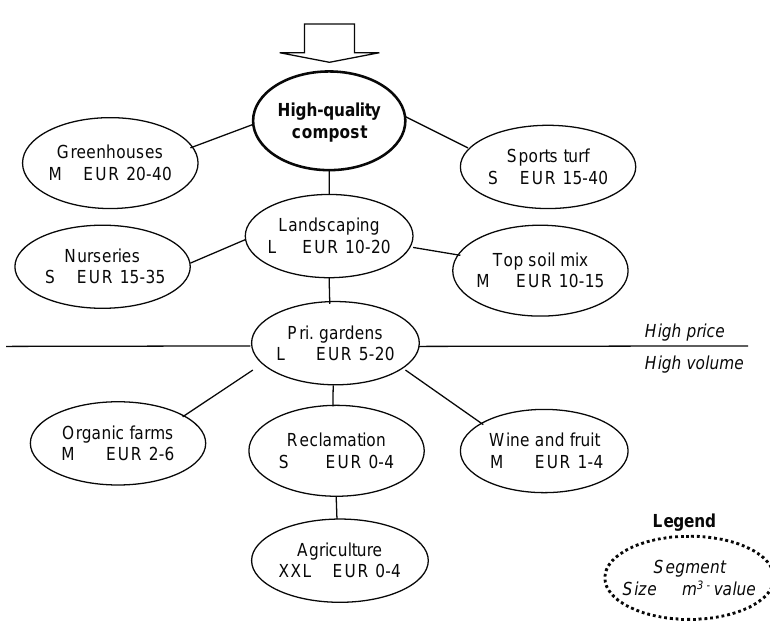
Figure 23: Compost marketing hierarchy indicating the relative size of the market segment small to extra-extra-large, as well as the known price range for compost product within the market segment, EUR/m 3 product. The prices are actual prices for ready to use products with compost, or pure composts, when the products are sold by the producer to the wholesaler or to the end user. (idea: Tyler, 1996; modified for European